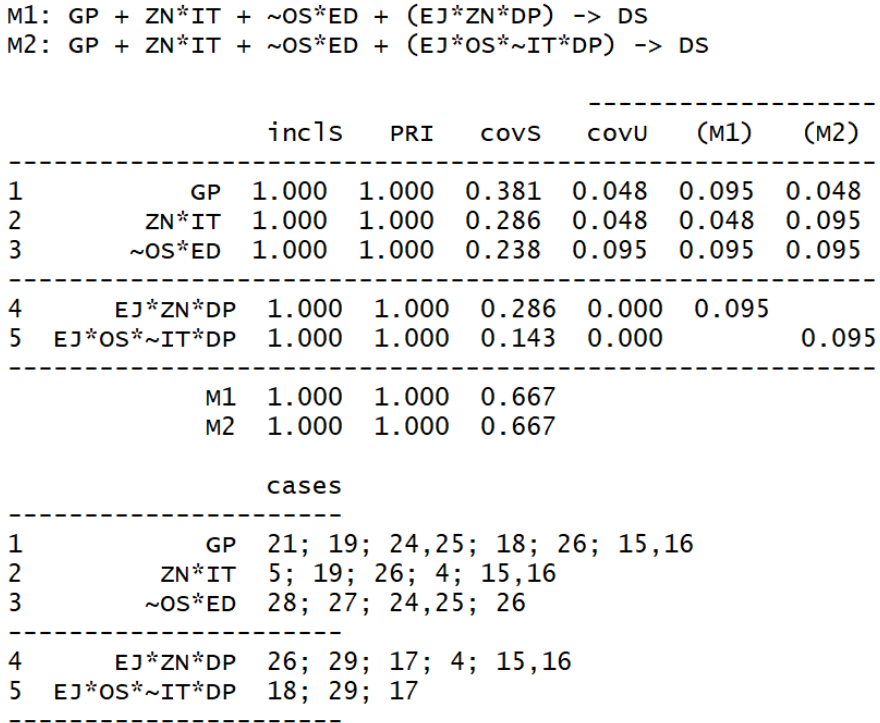
Figure 6. Economical solution to the research problem.